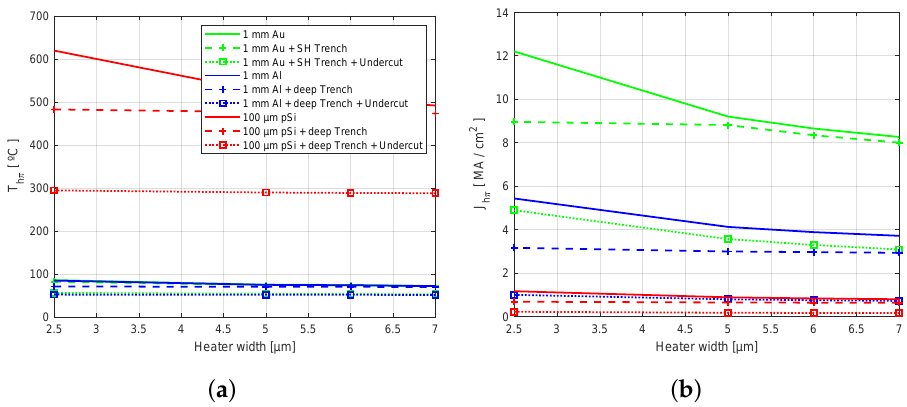
Figure 6. Temperature of the heater for ∆Φ π for the different heater widths and designs ( a ) and required current density ( b